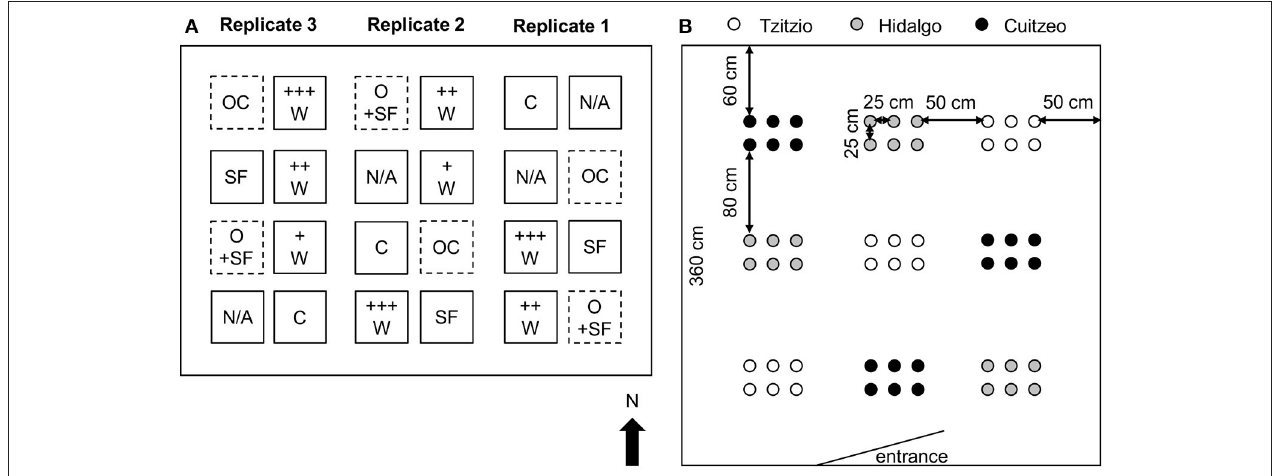
FIGURE 1 | Field design. (A) Layout for the three replicate parcels. Teosinte plants were placed in 360 × 360cm plots covered by a tent (C, SF, + W, ++ W, + + + W) or in open plots not covered by a tent (OC, O + SF). The labels refer to experimental treatments: tents not infested with herbivores (treatment C), tents infested with Spodoptera frugiperda larvae in the absence (SF) and in the presence of increasing densities of Campoletis sonorensis parasitoid wasps ( + W, ++ W, + + + W), and natural parasitism of S. frugiperda larvae in plots not covered by a tent (OC, O + SF). N/A: Not applicable (these plots were covered by a tent, but involved a separate experiment). The arrow points north. The drawing is not on scale. (B) Layout within each plot. Plants from three different teosinte populations, Tzitzio ( Zea mays ssp. parviglumis ), Hidalgo ( Z. mays ssp. mexicana ), and Cuitzeo ( Z. mays ssp. mexicana ), were placed in a tent in nine mini-plots in a randomized three-by-three Latin square, with six plants per mini-plot. Plants were placed in an identical arrangement in the open plots that were not covered by a tent.